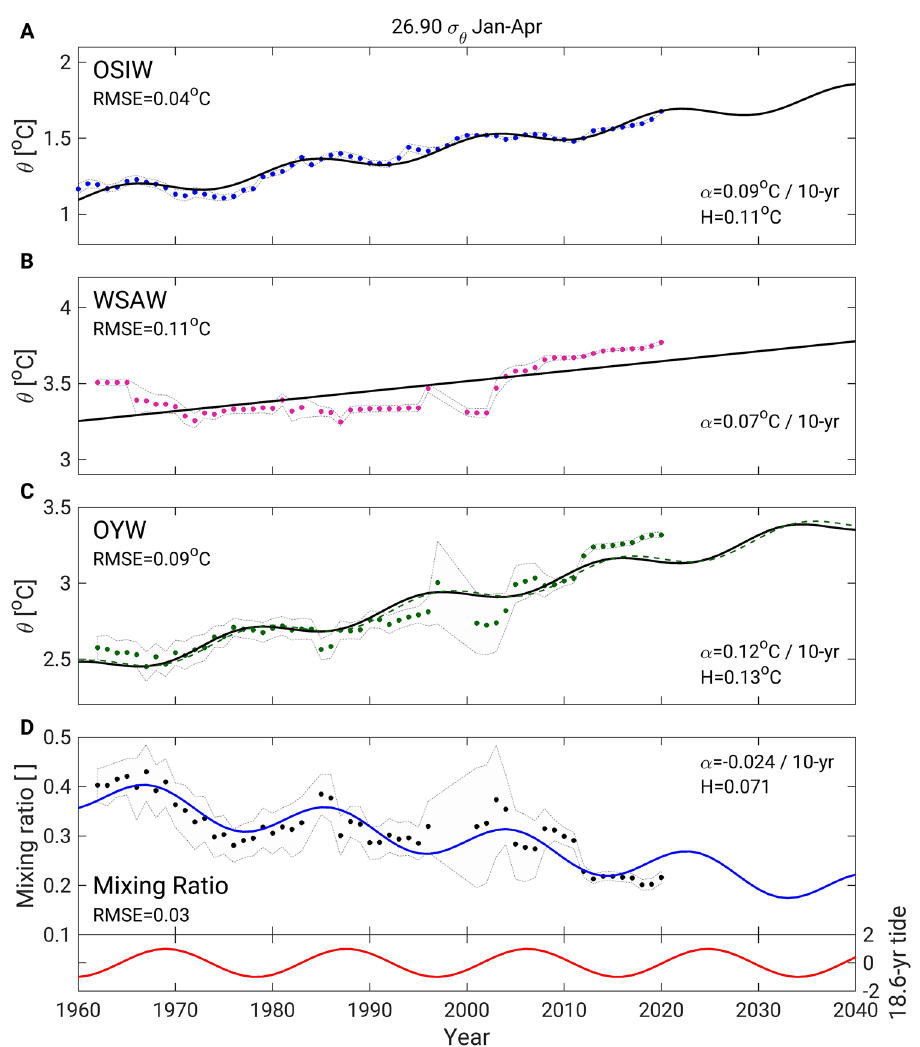
Figure 8. Time series of observed and predicted winter properties in the Sea of Okhotsk and western subarctic Pacific at 26.9 σ θ . Dots represent (mapped) observations, and lines predict data for ( A ) yearly-averaged OSIW, ( B ) January–April WSAW temperatures, ( C ) January–April OYW temperatures, and ( D ) January–April mixing ratio. In ( C ), the thin green dashed line represents predicted OYW temperatures estimated from Eq. (1). The red curve in the lower panel in ( D ) represents the 18.6-year diurnal tidal cycle. In each panel, the root mean square error (RMSE) indicates the root mean square error between observations and predictions, α indicates the linear 10-year trend, and H indicates twice the amplitude of the tidal signal (i.e., the difference over a half 18.6-year tidal period). In each panel, the light gray shading represents the 95% confidence interval (see “Methods” for details on the confidence interval